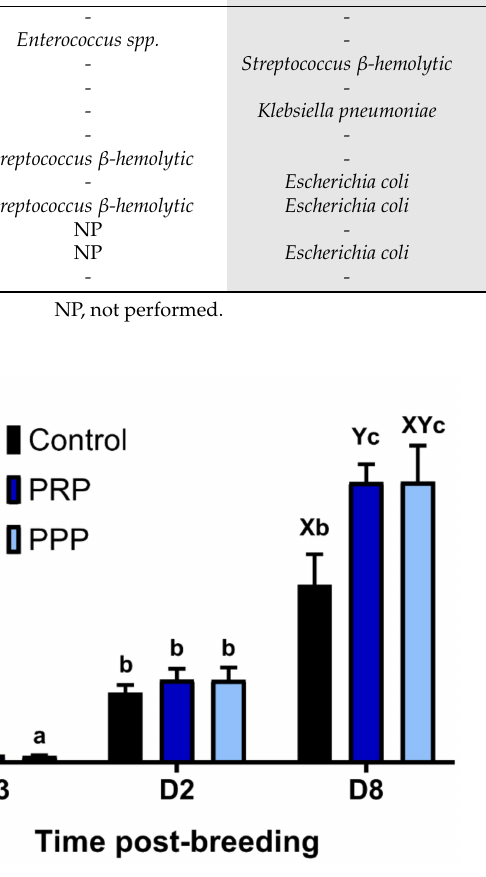
Figure 6. Circulating progesterone concentrations pre- and post-ovulation in mares susceptible to persistent breeding induced endometritis. Mares ( n = 12) had estrous cycles ( n = 34) assigned to receive intrauterine infusions with Lactate Ringer’s Solution (LRS) (Control, n = 12), platelet-rich (PRP n = 12), or -poor plasma (PPP n = 10) in a crossover design. Assessments were carried out from the early onset of estrus (D-3), 48 h post-ovulation (D2) and on the day of embryo flushing, eight days post-ovulation (D8): Different superscripts denote the effects of time ( a,b,c ) and differences between groups ( X,Y ) ( p <